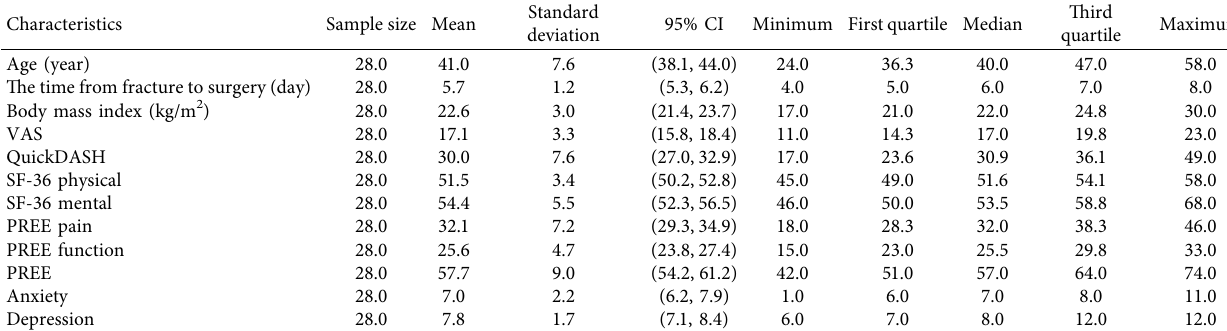
Table 1: Demographic characteristics of CRPS I Patients.